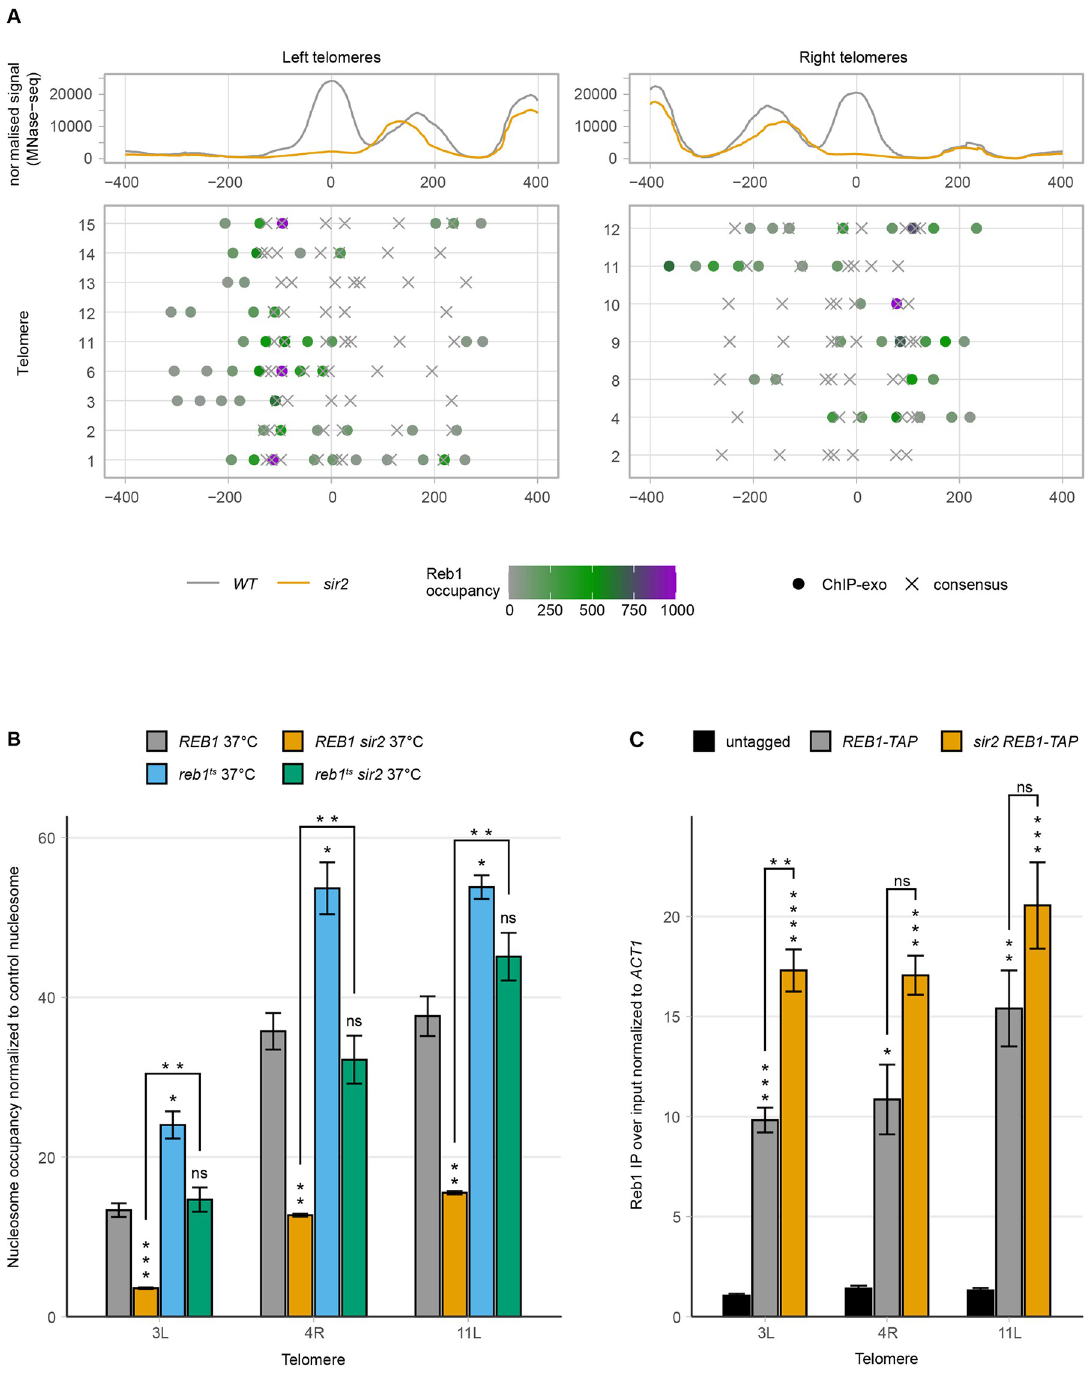
Fig 3. Reb1 binds to subtelomeres and destabilizes nucleosomes. ( A ) Meta-X-element analysis of 9 left and 7 right telomere ends. The top panel shows the normalized MNase-seq signal of WT (grey) and sir2 (orange) centered on the summit of the nucleosome with the highest occupancy change. In the middle panel, Reb1 consensus sites (X) and occupancy (dots) presented as a heat map are shown for the individual X-elements. ( B ) MNase-qPCR of WT and sir2 strains carrying a deletion of the endogenous REB1 gene and expressing either a WT or mutant temperature-sensitive plasmid-borne allele of REB1 . Strains were grown at restrictive temperature. ( C ) Chromatin immunoprecipitation followed by qPCR of the indicated strains. Ct values were first normalized to ACT1 , followed by normalization to input. All data are shown as mean ± SEM (n = 3, � p < 0.05, �� p < 0.01, ��� p < 0.001, ���� p < 0.0001, ns = not significant).